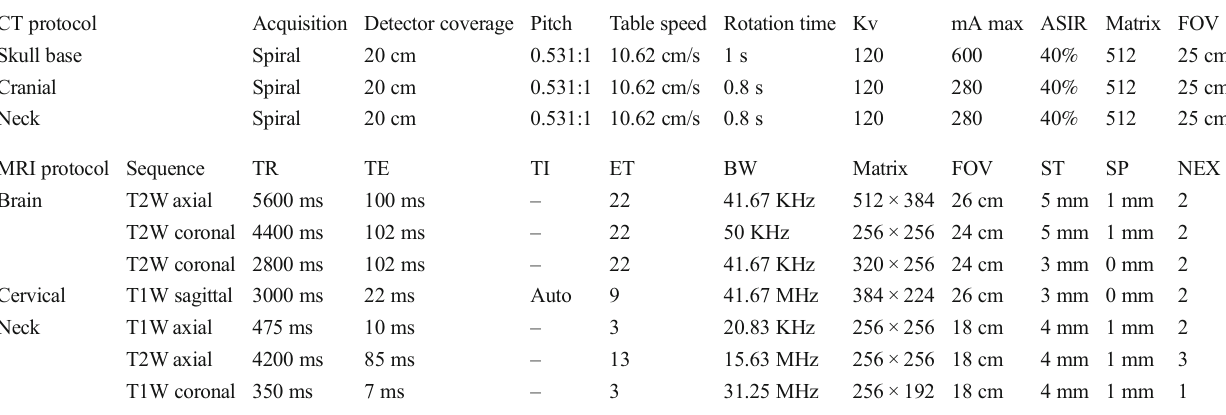
Table 1 Clinical computed tomography (CT) and magnetic resonance imaging (MRI) protocols used in the current review CT protocol Table speed Rotation time